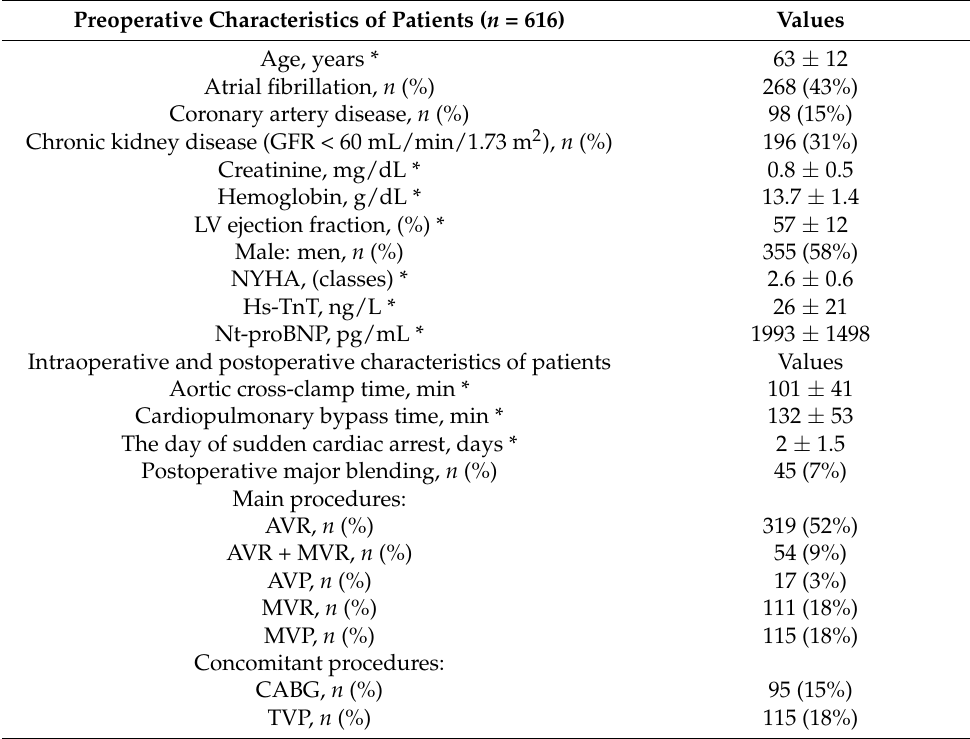
Concomitant procedures: CABG, n (%) TVP, n (%) 115 (18%) Values are represented by the mean * and a measure of the variation of the internal standard deviation. Abbre- viations: AVP = aortic valve plasty; AVR = aortic valve replacement; CABG = coronary artery bypass grafting;